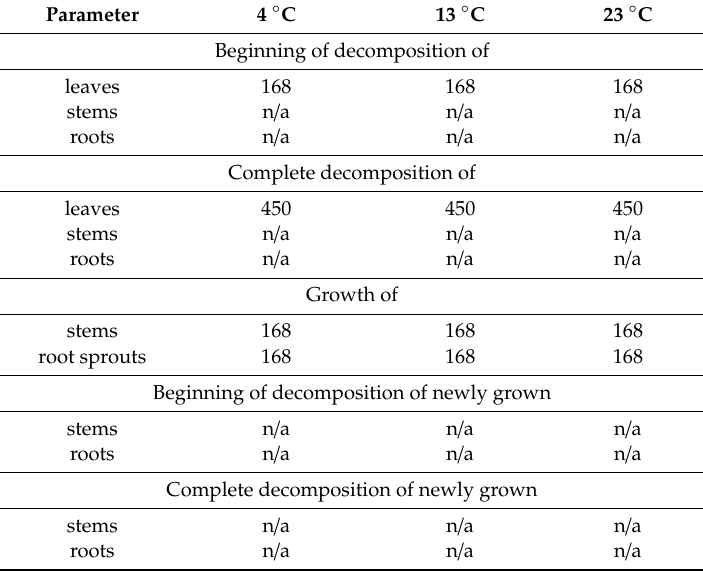
Table 1. Results from simulated flooding experiment (in hours). Visible morphological changes of di ff erent parts of the specimens (leaves, stems, and roots) were assessed in 12 parameters. (n / a—not